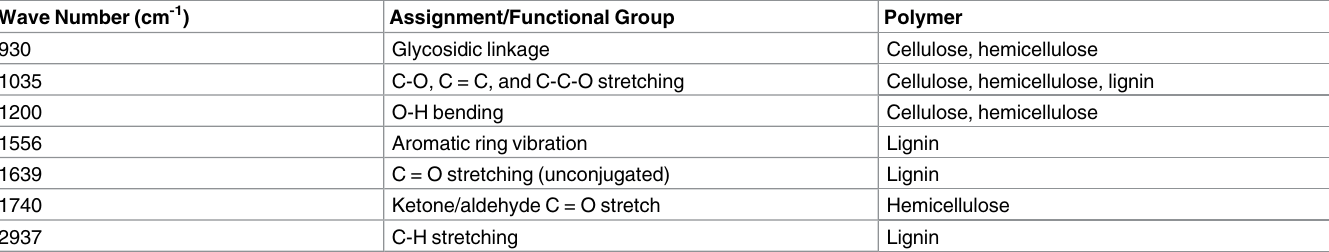
Table 7. Assignment of functional group and their corresponding polymer in wild mushrooms. Wave Number (cm -1